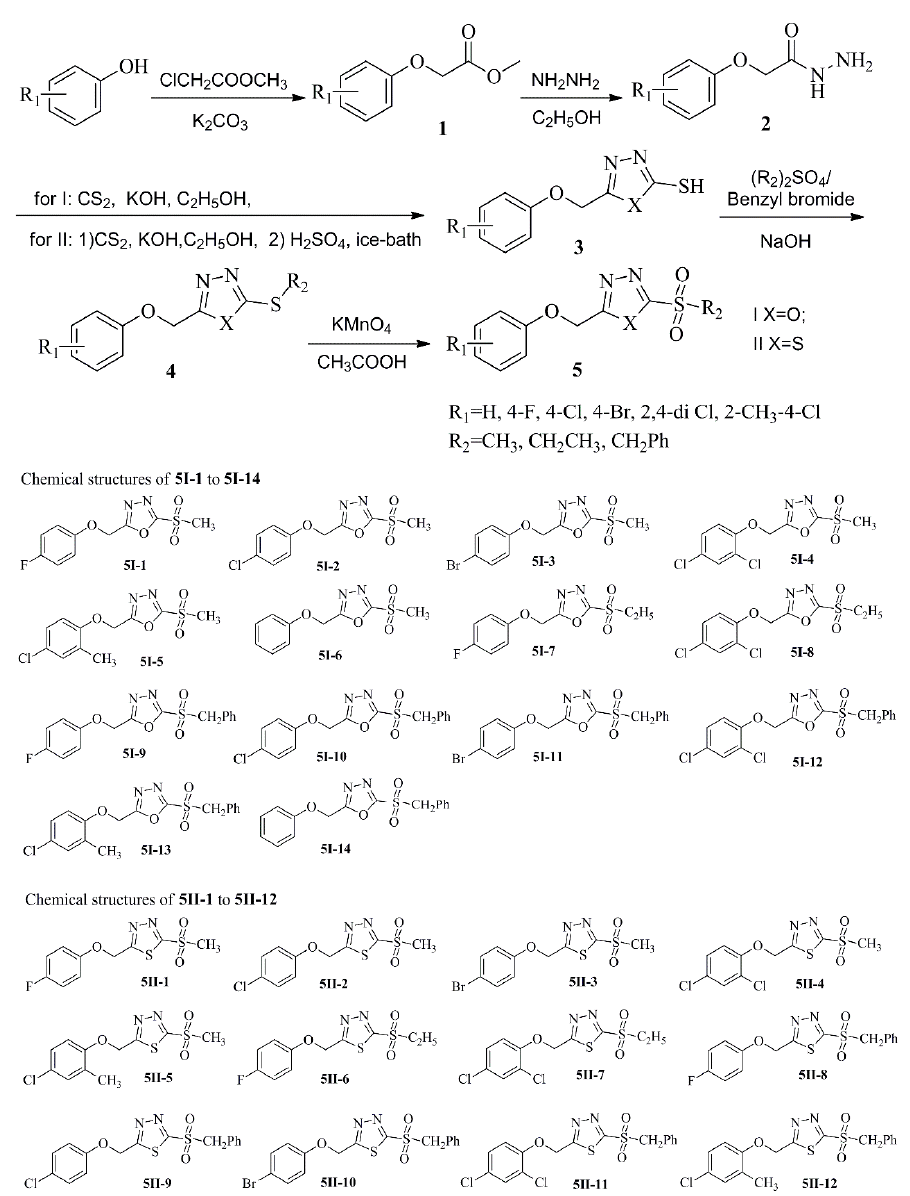
Figure 2. Synthetic Route to the Target Compounds 5I-1 – 5I-14 and 5II-1 – 5II-1 .